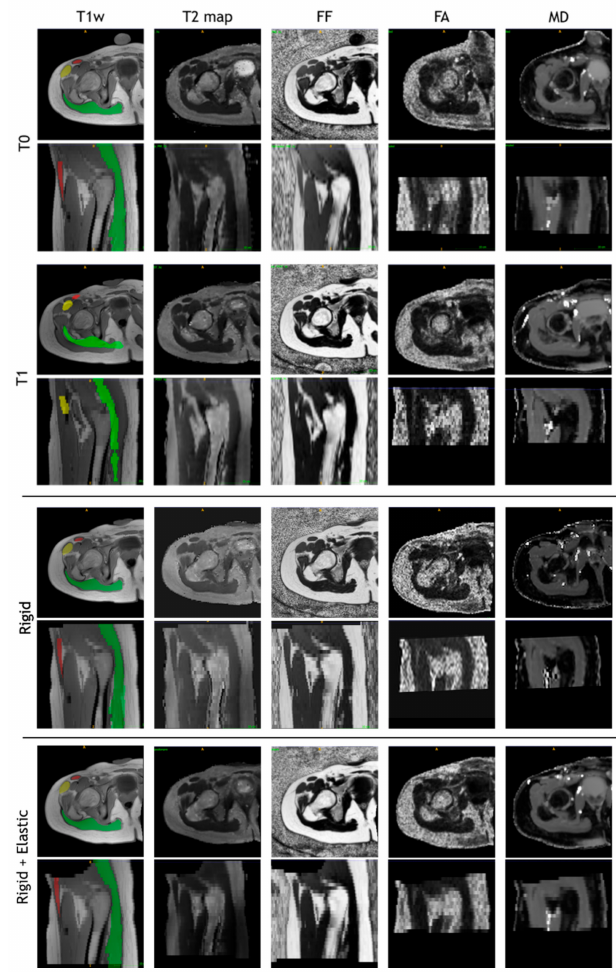
Figure 10. T1-w, T2 map, fat fraction, fractional anisotropy, and mean di ff usivity map after intra-session rigid registration and rigid and non-rigid registration steps of a sample